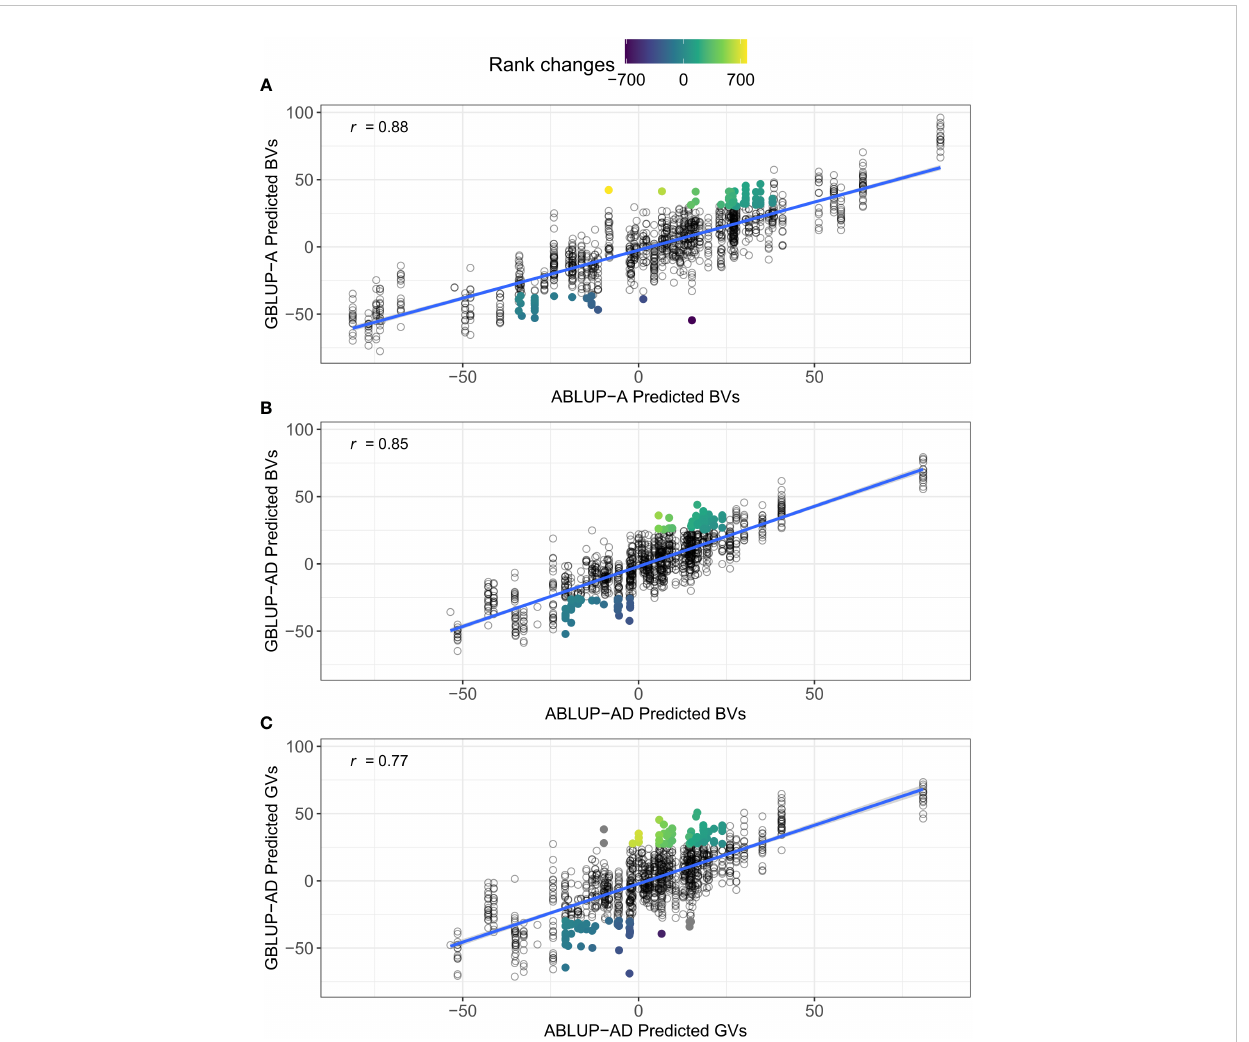
FIGURE 5 Comparisons between the predicted breeding (BVs) and genetic values (GVs) between ABLUP and GBLUP. An example is shown for height growth on site Asselin (dataset 1) and the cross-validation scenario CV2, which simulated the prediction of new unphenotyped families. (A) correlation between the predicted BVs from ABLUP-A and GBLUP-A; (B) correlation between the predicted BVs from ABLUP-AD and GBLUP-AD; and (C) correlation between the predicted GVs from ABLUP-AD and GBLUP-AD. The Pearson correlation coef fi cient ( r ) is given for each panel. In each panel, the top and bottom 10% individuals that would be selected or culled using only GBLUP, but not using ABLUP, are highlighted. The color gradient for highlighted individuals represents the rank changes between ABLUP and GBLUP selections. The overlap between ABLUP and GBLUP top and bottom 10% trees was 73% in (A) , 64% in (B) , and 55% in (C) . Note that under ABLUP, only the mid-parent breeding values can be assigned in the absence of phenotypes. Also, for ABLUP-AD and CV2, the predicted dominance deviations were null for all individuals, such that the predicted BVs (x-axis in B ) were equal to the predicted GVs (x-axis in C